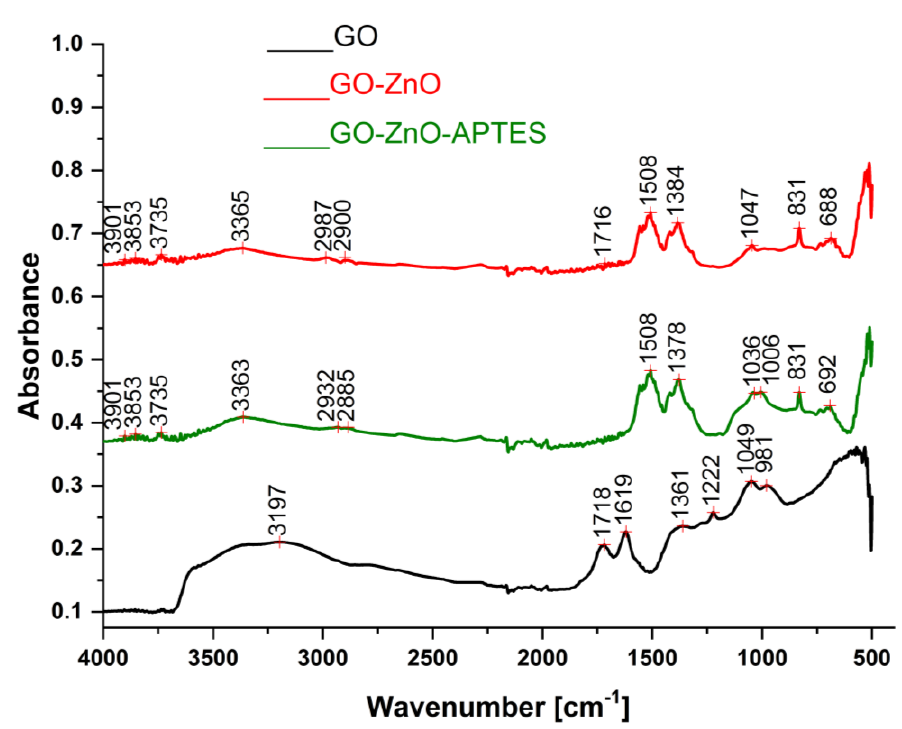
Figure 4. FT-IR spectra of graphene oxide (GO), graphene oxide with zinc oxide (GO-ZnO) and silanized graphene oxide with zinc oxide (GO-ZnO-APTES).